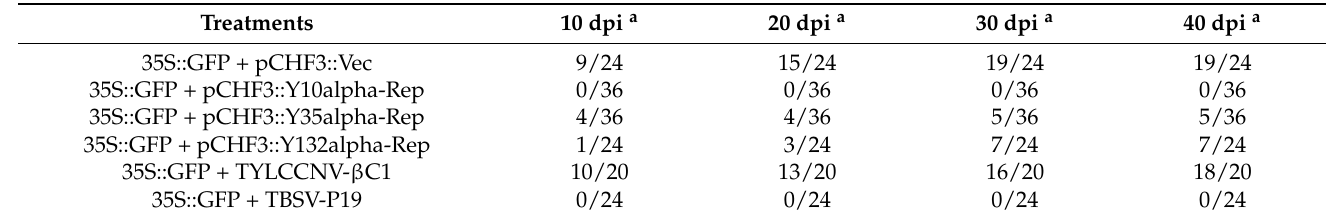
Table 1. Suppression of systemic GFP silencing by alpha-Reps in transgenic N. benthamiana 16c plants at different days post infiltration